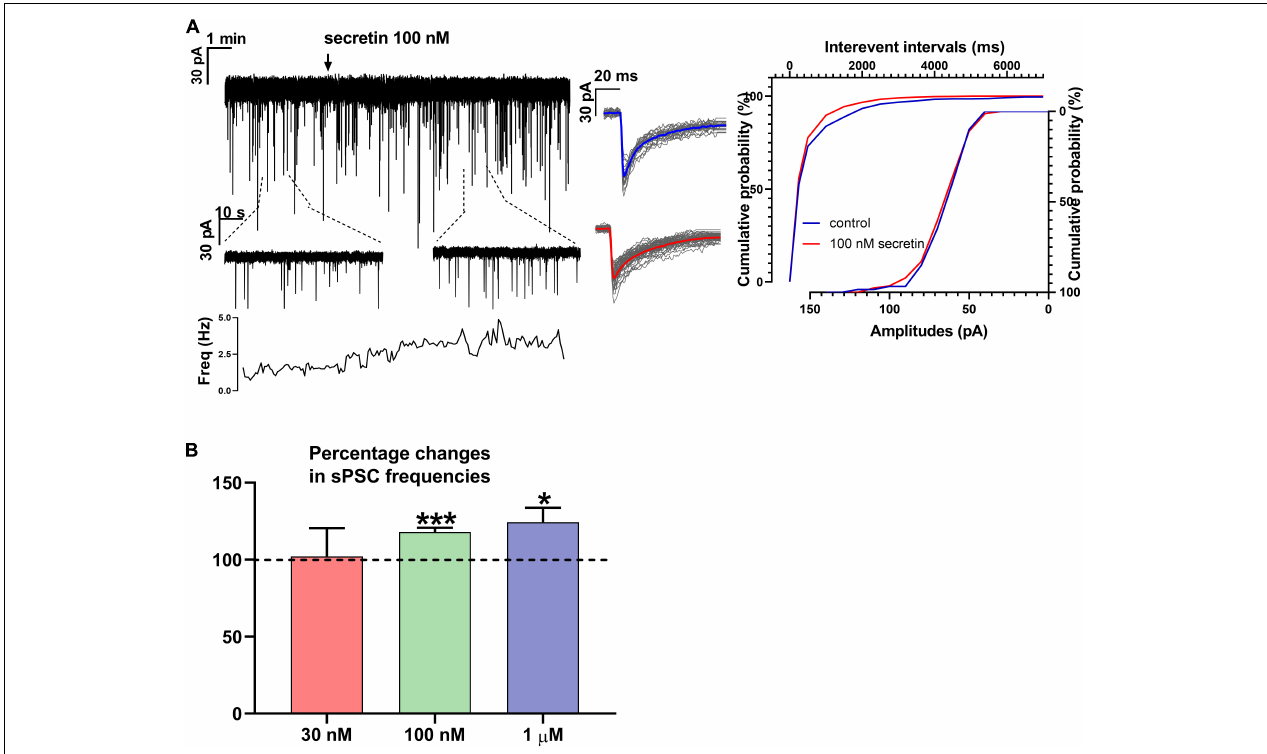
FIGURE 1 | Secretin increases the frequency of sPSC in GnRH neurons. (A) Secretin increased the frequency of the sPSCs with no change in the average amplitude and shape. Average sPSCs next to the recording represent no change in the shape of events after secretin treatment. The inserts below the 15 min recordings are 1-1 min zoomed periods from the recordings before and after secretin administration. The frequency distribution graph under the inserts also reveals that secretin application elevated the sPSC frequency. Cumulative probabilities of the interevent intervals and amplitudes are also presented. (B) The bar graph shows that effect of secretin increasing the sPSC frequency is dose dependent (Student’s t -test ∗ p < 0.05; ∗∗∗ p < 0.001). TABLE 1 | Changes in the frequency of PSCs after secretin treatment. Frequency of control After secretin in Hz Average percentage n period in Hz changes after secretin